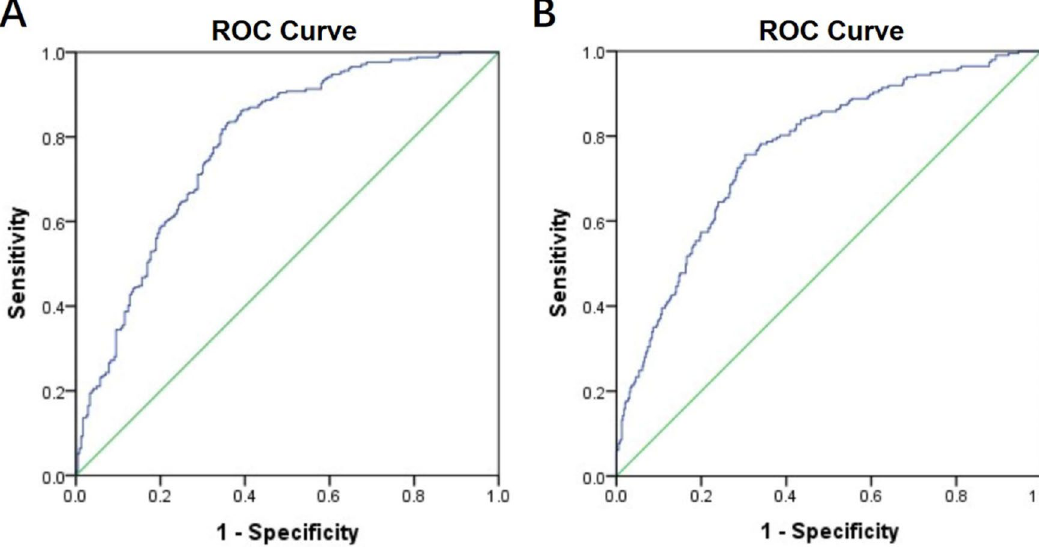
Figure 1. Receiver-operator characteristic (ROC) curve to identify obstructive sleep apnea (OSA). ROC curves for the clinical factors including male, age, body mass index, hypertension and left ventricular outflow tract obstruction to identify the presence of OSA ( A ) as well as the presence of moderate to severe OSA ( B